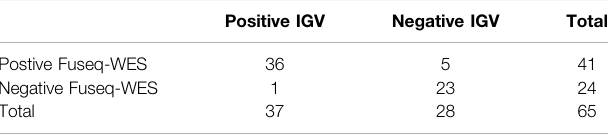
TABLE 3 | Comparison of detection results for TMPRSS2-ERG fusion in ProBio patients using the IGV and Fuseq-WES methods. Overall there is 91% concordance between the two methods.